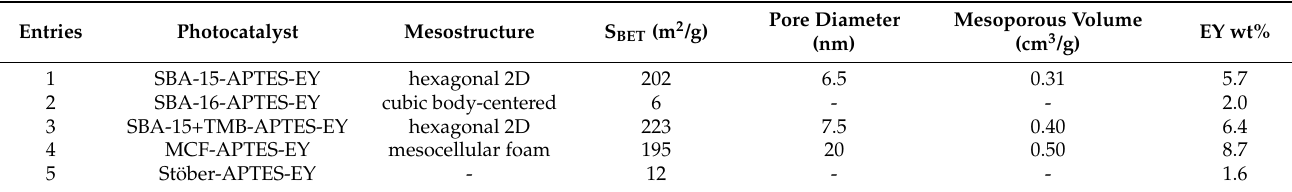
Table 1. Textural properties of heterogeneous photocatalysts and EY loading.